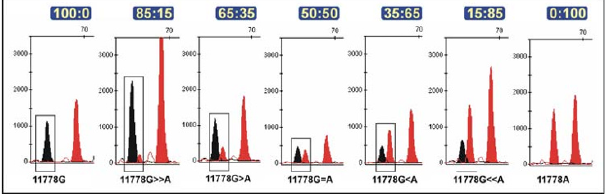
Figure 2 Partial electropherograms showing the performance of the SNaPshot assay with mixtures of wild:mutant DNAs. Num- bers in the top indicate the percentages of wild:mutant mix-